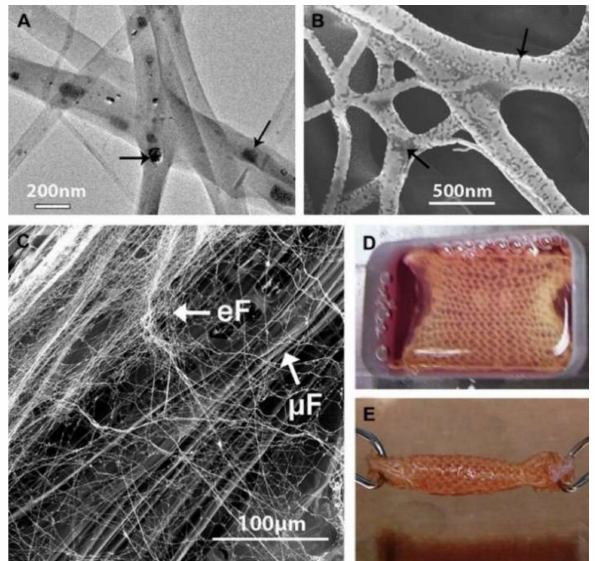
Figure 6. ( A ) TEM and ( B ) back-scattered SEM images of electrospun bFGF-containing PLGA fibers showing the random distribution of proteins (indicated by black arrows) in the fibers; ( C ) SEM image of biohybrid sca ff old developed by coating FGF( + ) electrospun fibers (eF) on microfibrous knitted silk sca ff olds (mF); ( D , E ) BMSC-seeded biohybrid sca ff old cultured in a custom-made chamber before being rolled up into cylindrical ligament / tendon analogs after seven days of culture [85]. Reproduced with permission from Elsevier,